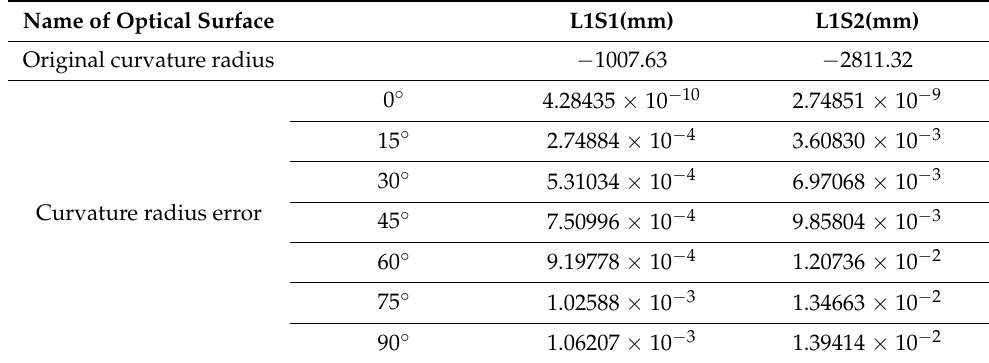
Table 5. Curvature radius